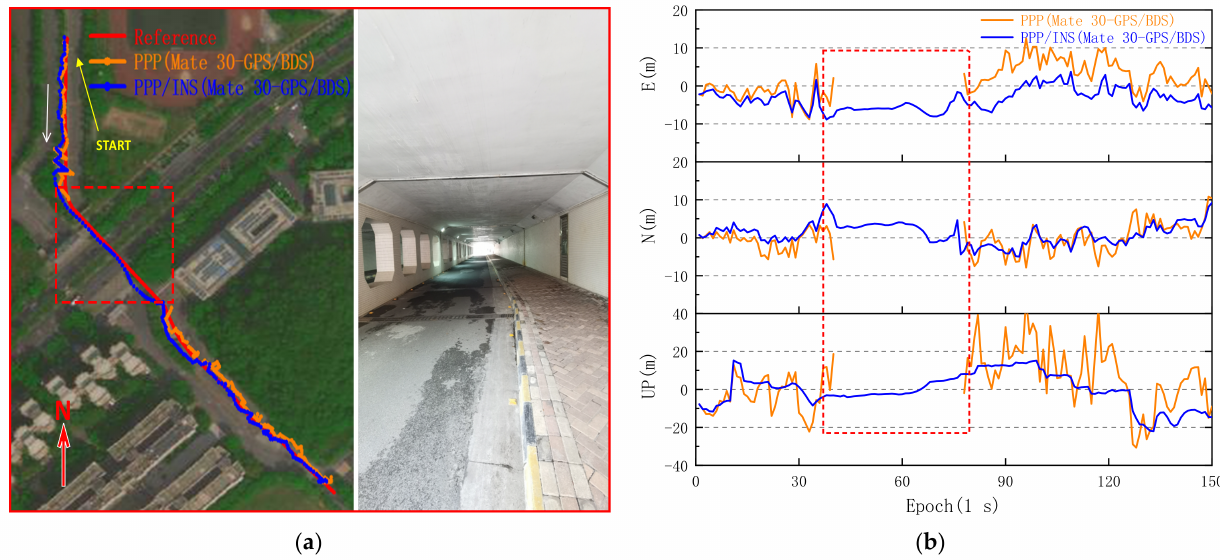
Figure 15. GPS/BDS PPP and PPP/INS solutions from Huawei Mate 30 in the tunnel. ( a ) Left: trajectories of GPS/BDS PPP and PPP/INS solutions. Right: the realistic environment marked in the red box. ( b ) Comparison of GPS/BDS PPP and PPP/INS solutions with reference points, and the red box shows the GPS/BDS PPP/INS solutions in the